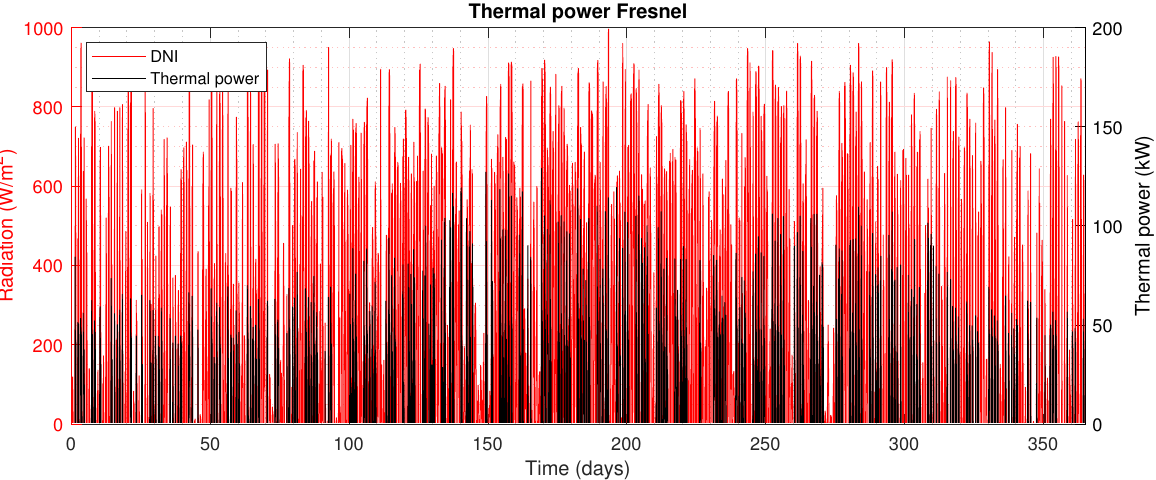
Figure 10. Thermal power of the